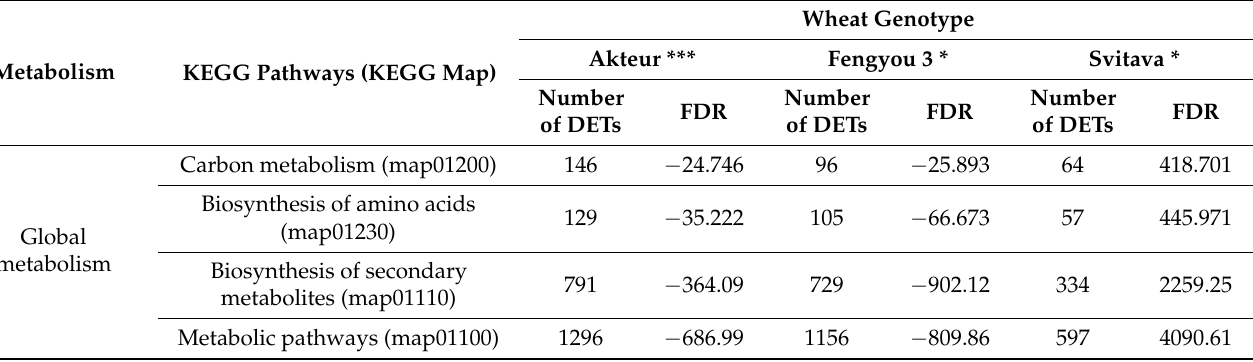
Table 1. List of top metabolic pathways as revealed by KEGG enrichment analysis, showing the number of DTEs that were mapped to different KEGG pathways and its collective log2 fold change